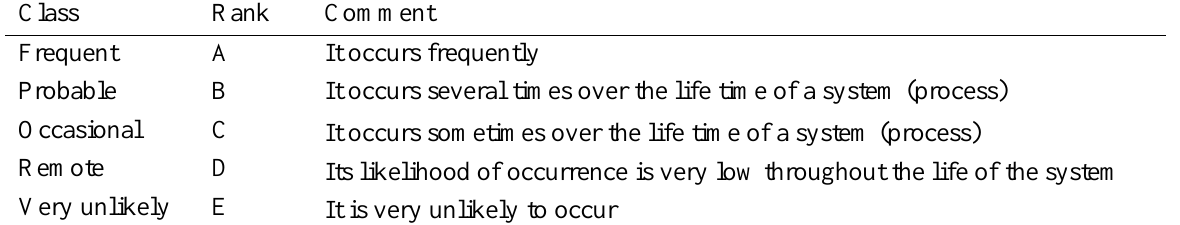
Table 2. Hazard probability in PHA (Halvani, 1998)